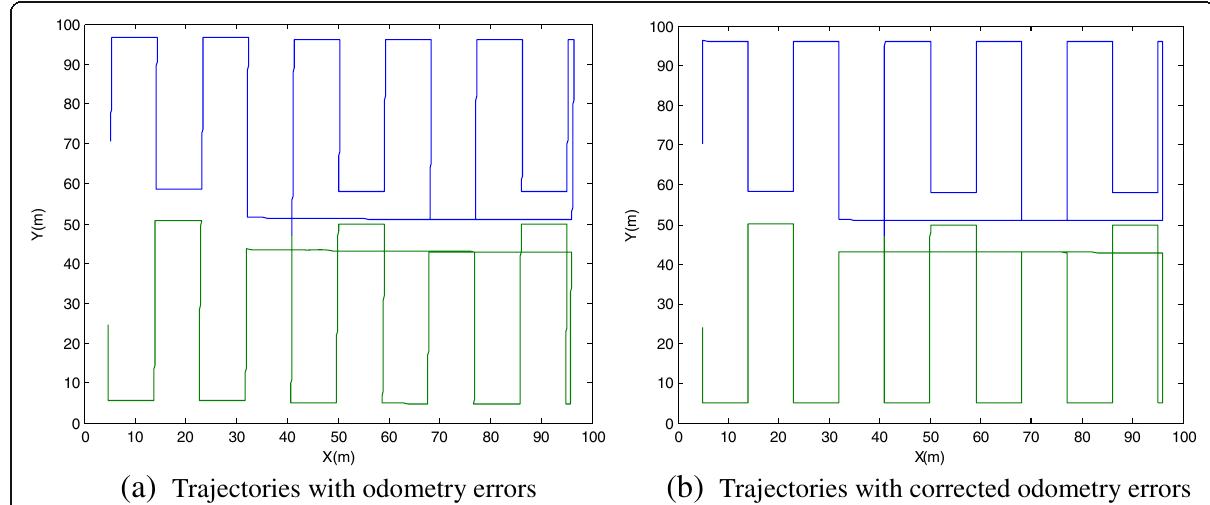
Fig. 4 Exploration trajectories of a multi-robot system composed of two robots; in the figure, blue and green trajectories correspond to r 1 and r 2 ,